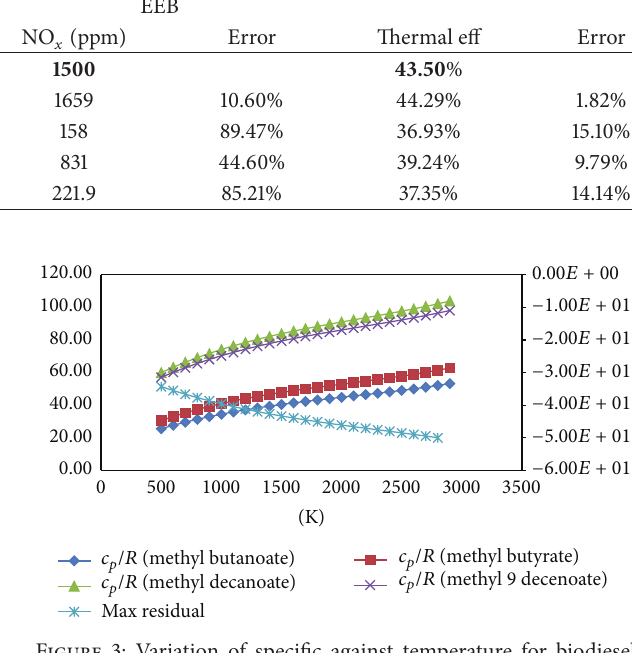
Figure 2: Variation of entropy against temperature for biodiesel surrogates.